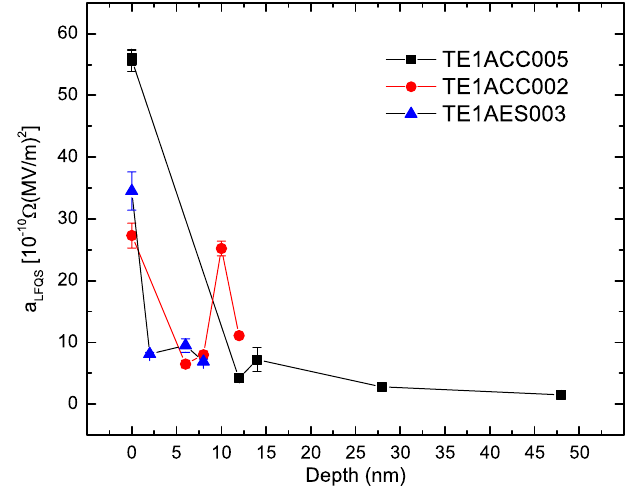
FIG. 7. LFQS fit results for the slope-defining parameter a as a function of material removal depth. Error bars describe standard errors of the